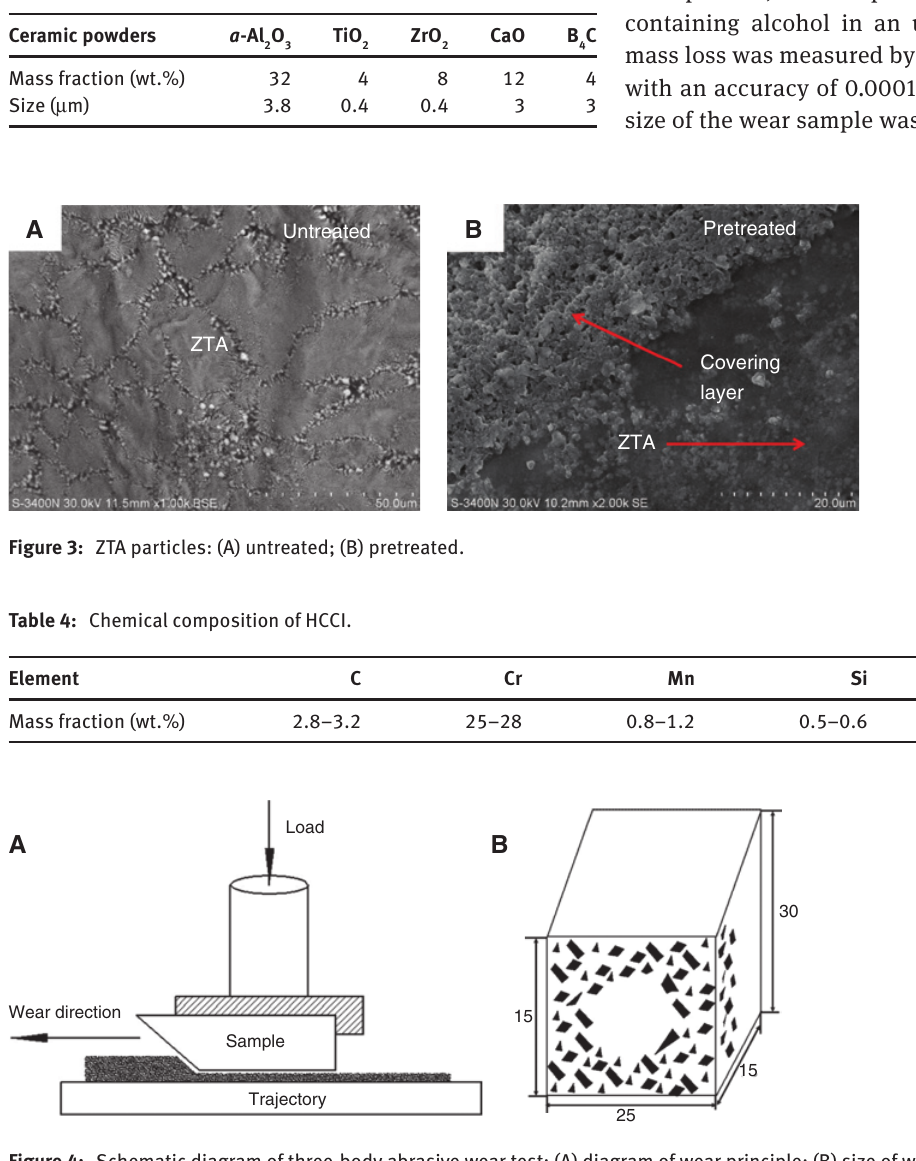
Figure 4: Schematic diagram of three-body abrasive wear test: (A) diagram of wear principle; (B) size of wear